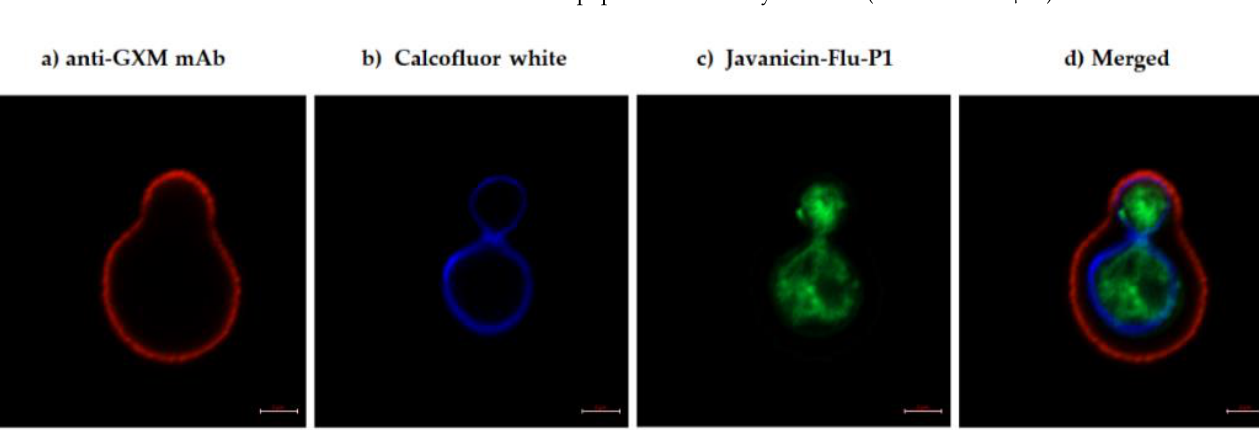
Figure 4. Fluorescent staining for r-javanicin localization in C. neoformans H99 using confocal laser scanning microscope (CLSM). A budding yeast cell was stained with three fluorescent stainings, red color of anti-GXM mAb specific for polysaccharide capsule followed by Alexa 568-conjugated goat anti-mouse Ig G ( a ), blue color of calcofluor white (CFW) specific for cellulose and chitin in fungal cell wall ( b ) and green color of Flu-P1 labeled r-javanicin ( c ). Merge of triple-fluorescent staining was represented ( d ). It was implied that r-javanicin localized in cytoplasm of C. neoformans . All photos were taken at the same magnification (scale bar = 2 µm).